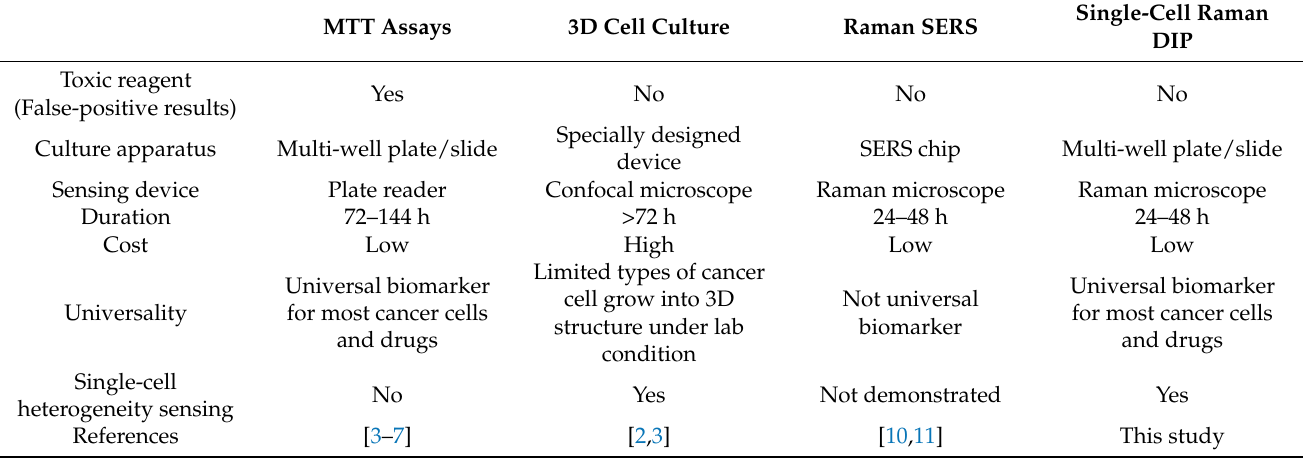
Table 2. Comparison of some in vitro anticancer drug efficacy screening techniques. MTT